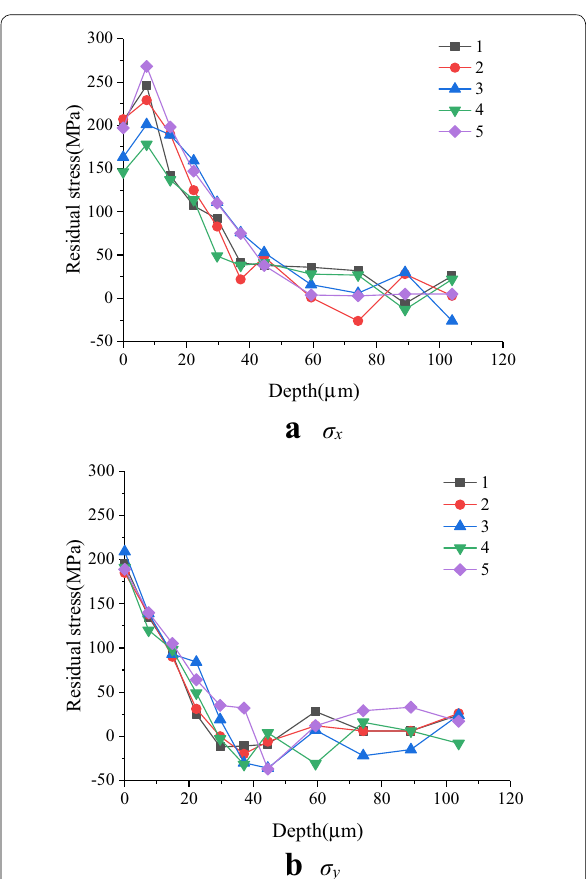
Figure 8 Residual stress along the depth direction of samples 1 ‒ 5